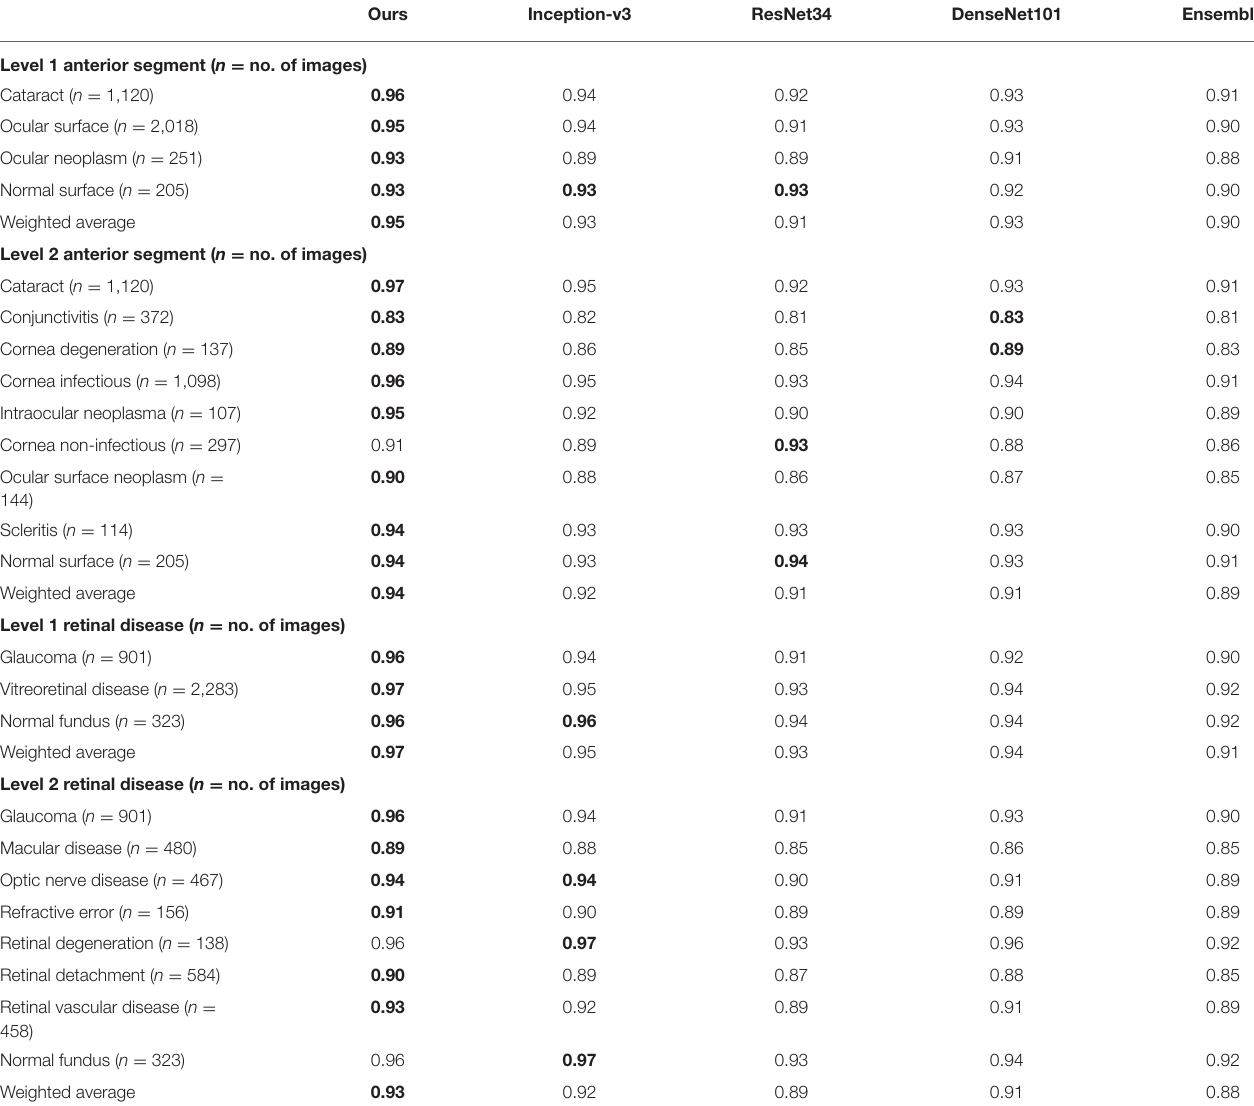
TABLE 2 | AUC comparison between the proposed hierarchical deep learning framework and existing deep learning frameworks. Ours Inception-v3 ResNet34 DenseNet101